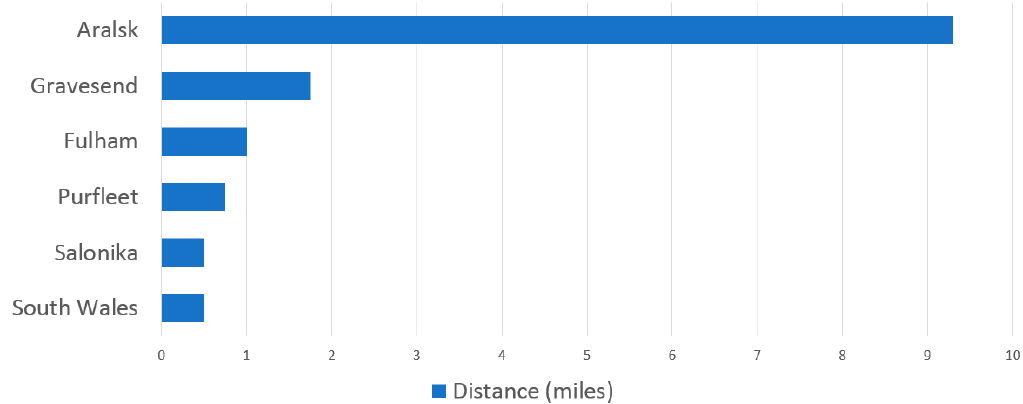
Figure 2. Maximum reported distance (miles) of aerial convection of smallpox in different outbreaks, where distance was quantified.